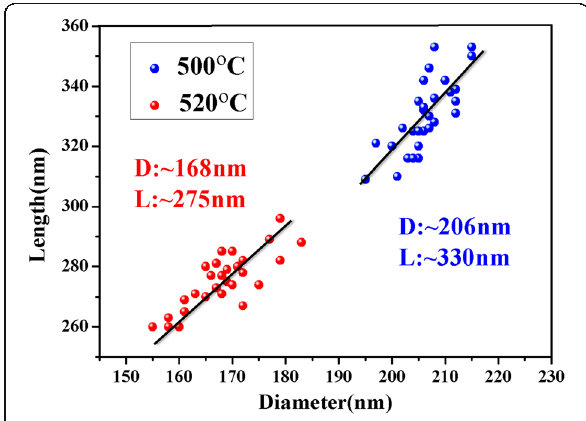
Fig. 3 Statistical data of the diameter and length of the GaSb nanowires grown at 500 and 520